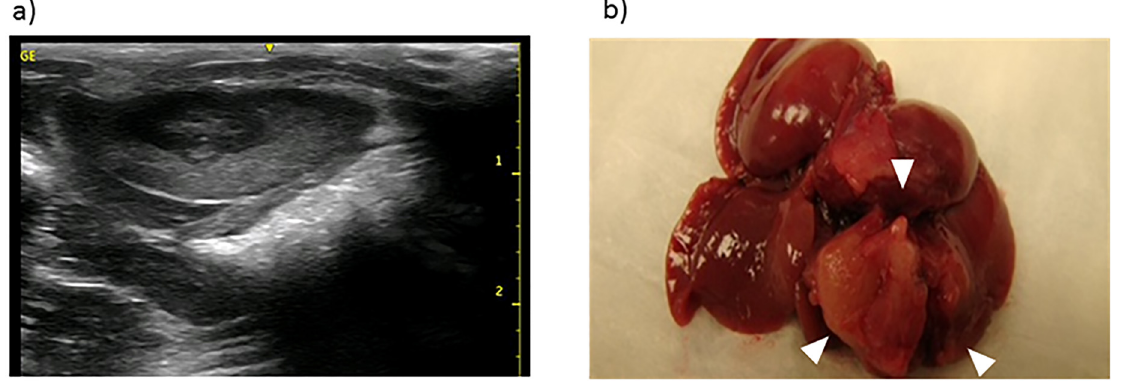
Fig 2. Ultrasound and Gross Pathology. (a) Transverse ultrasound images demonstrates a well-defined hypoehoic tumor in the anterior aspect of the left hepatic lobe. (b) Explanted gross specimen reveals tumors corresponding to the lesions seen on US (arrow